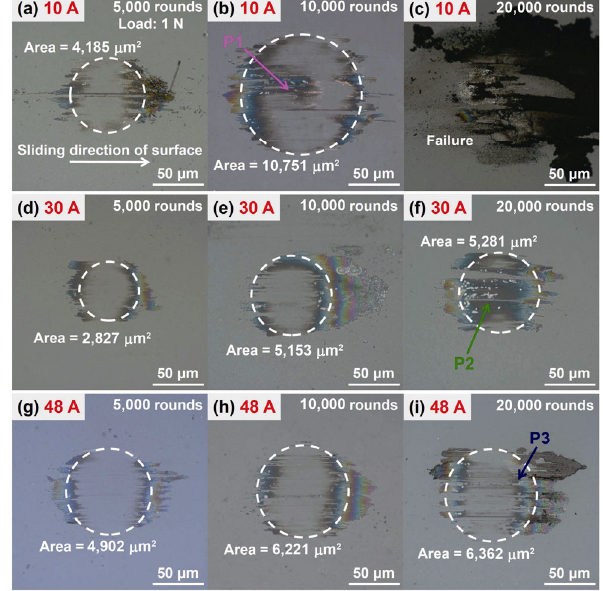
Fig. 4 Frictional curves with I s of 10, 30, and 48 A at a load of 1 N.